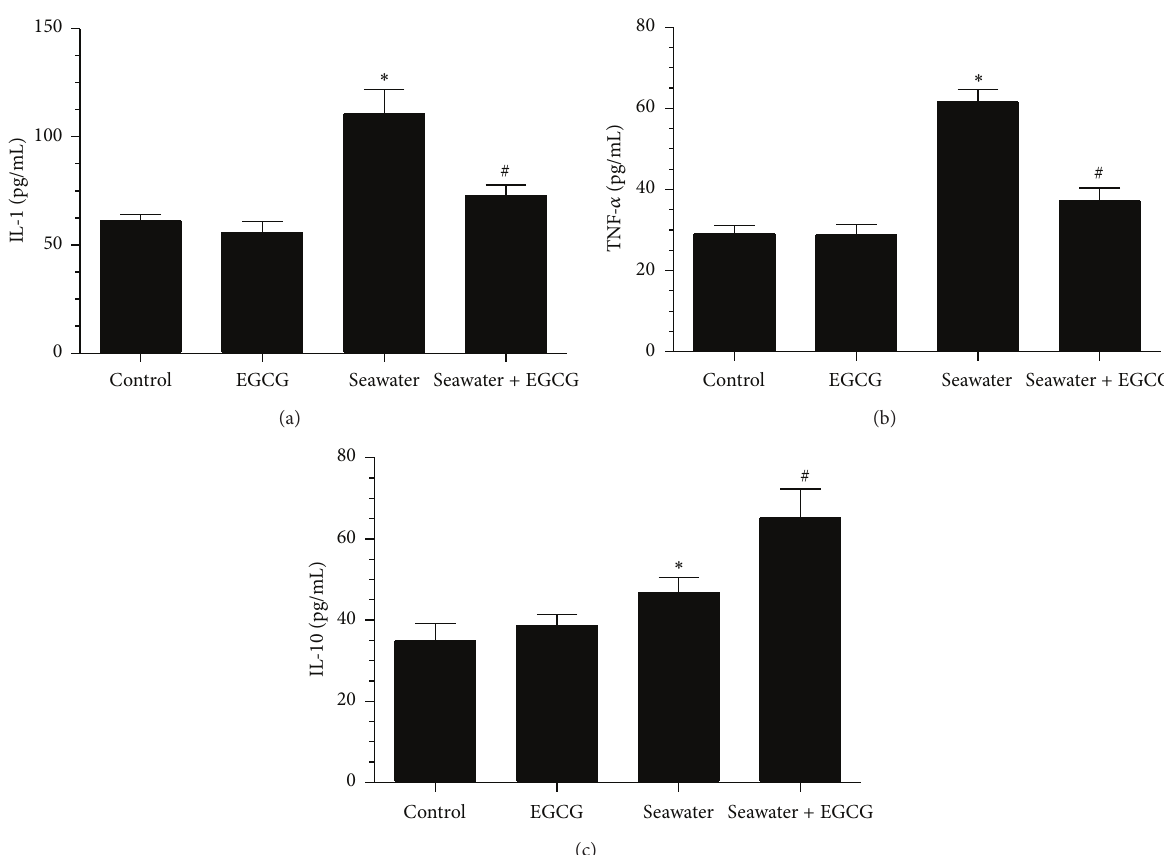
Figure 9: Effects of EGCG pretreatment on IL-1, TNF- 𝛼 , and IL-10 in NR8383 cells. IL-1 (a), TNF- 𝛼 (b), and IL-10 (c) increased in seawater group. EGCG pretreatment decreased IL-1 and TNF- 𝛼 but increased IL-10. Data were presented as mean ± SEM ( 𝑛 = 12 ). ∗ 𝑃 < 0.05 versus control group; # 𝑃 < 0.05 versus seawater group.